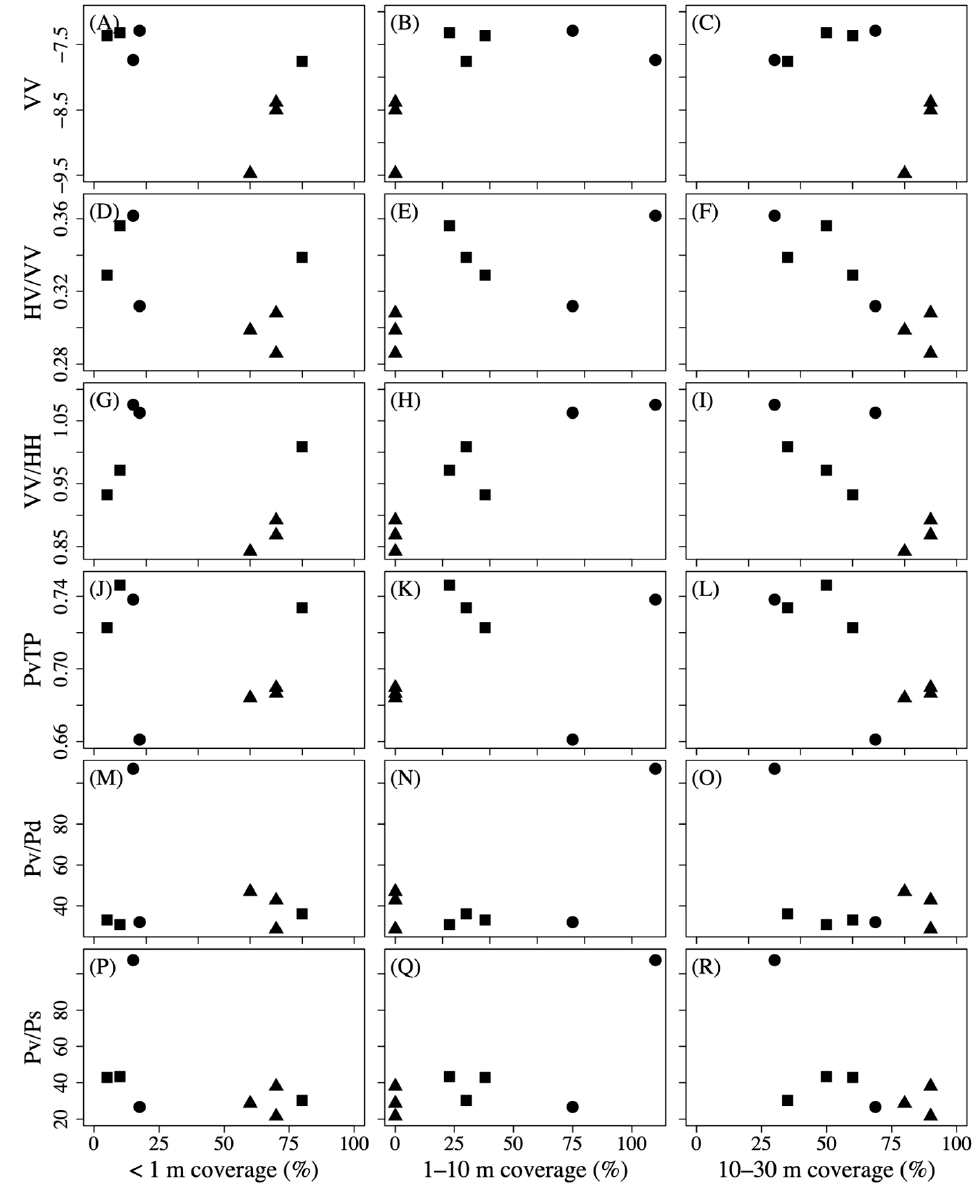
Figure 5. Scatter plots of vegetation coverage (%) and polarimetric parameters that show significance association (Table 4). The plots on the left represent vegetation coverage of less than 1 m on the x -axis, the central column of plots represents vegetation coverage between 1 m and 10 m, and the right-hand plots represent vegetation coverage between 10 m and 30 m. The y -axis shows each polarimetric parameter: ( A – C ) σ 0 VV, ( D – F ) HV/HH, ( G – I ) VV/HH, ( J – L ) PvTP, ( M – O ) Pv/Pd, and ( P – R ) Pv/Ps. The circle, triangle, and square points correspond to surveyed data on natural peat swamp forest (NPF), planted acacia forest (PAF), and Jungle rubber forest (JRF), respectively.